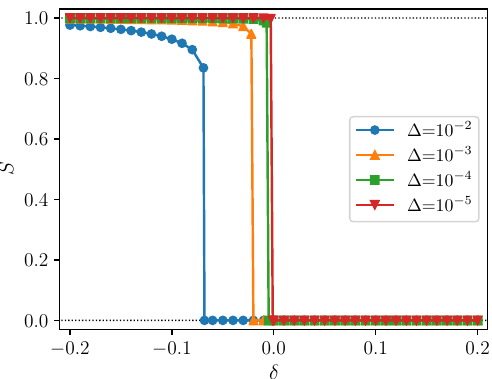
Figure 1. Size of the giant weak percolation component S after the cascade of failures following the removal of edges with probability (cid:31) in simulations of uncorrelated networks with N edges, as a function of reduced control parameter δ damage, the behavior converges to a novel discontinuous transition. The degree distribution is P ( 0 ) 1 ) e − c c q − 1 /( q and P ( q ) for q > 0 , with c such that P ( 1 ) = − ! realizations of the network and damage. Lines are simply a guide to the